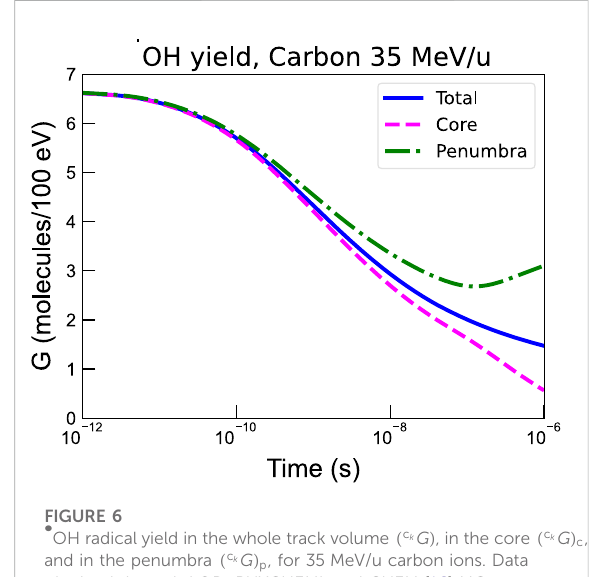
FIGURE 6 (cid:129) OH radical yield in the whole track volume ( c k G ) , in the core ( c k G ) c , and in the penumbra ( c k G ) p , for 35 MeV/u carbon ions. Data obtained through LQD, PHYCHEML and CHEM [16] MC